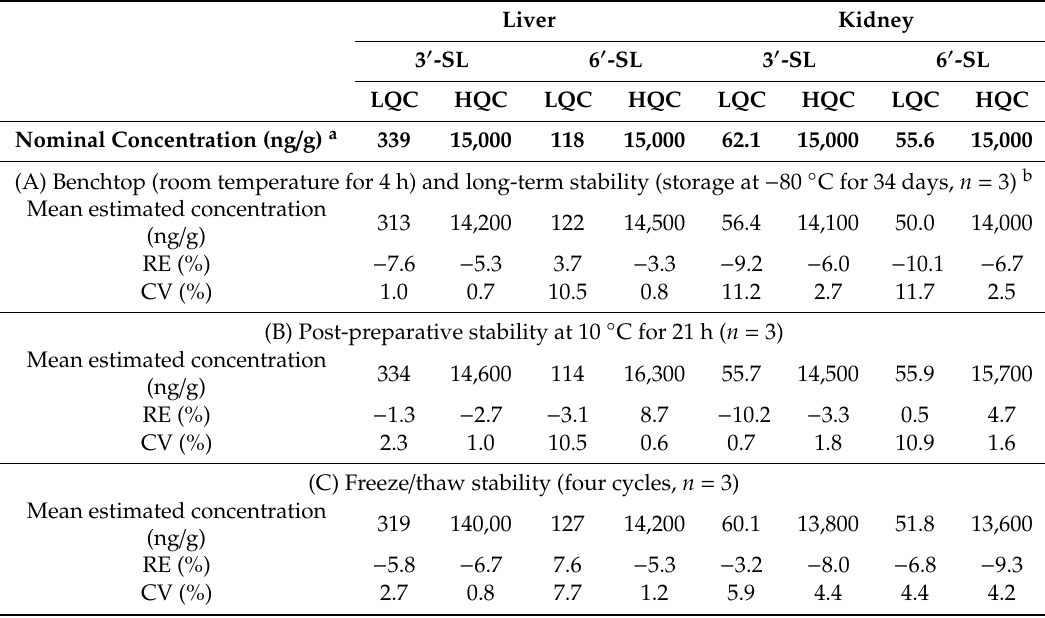
Table 5. Biological sample stability.